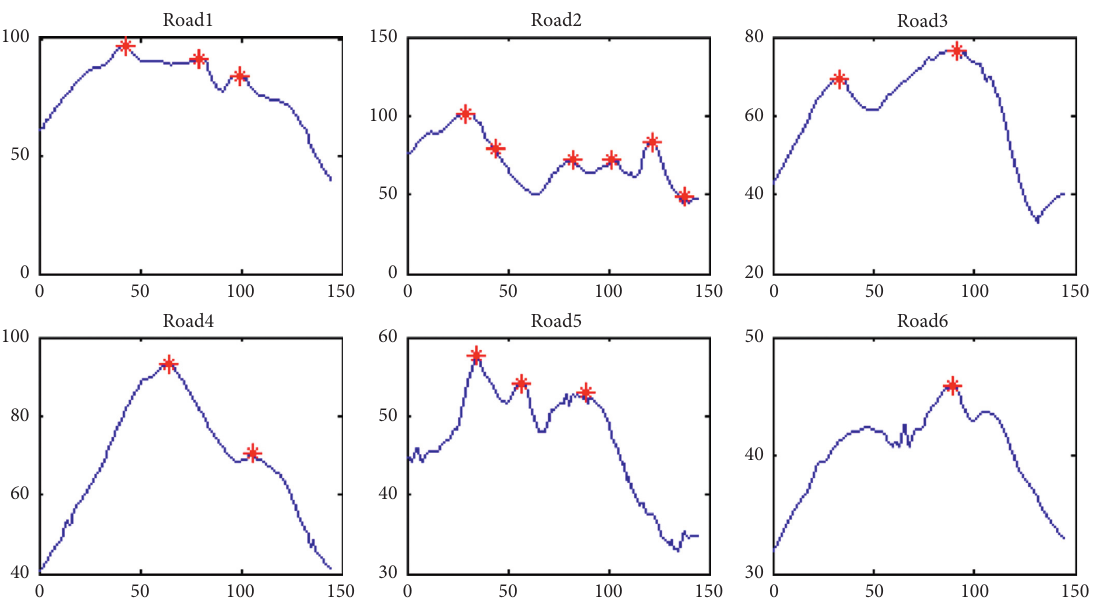
Figure 20: The data smoothed with the wavelet sym5 and the peaks picked. Table 4: Comparing to the smoothing methods with a best